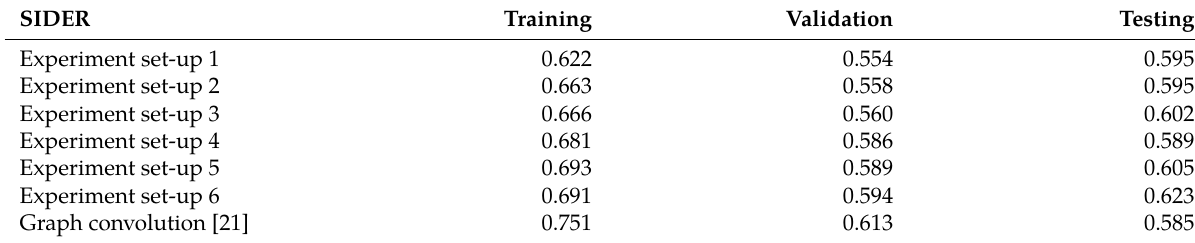
Table 1: Results for the SIDER dataset.